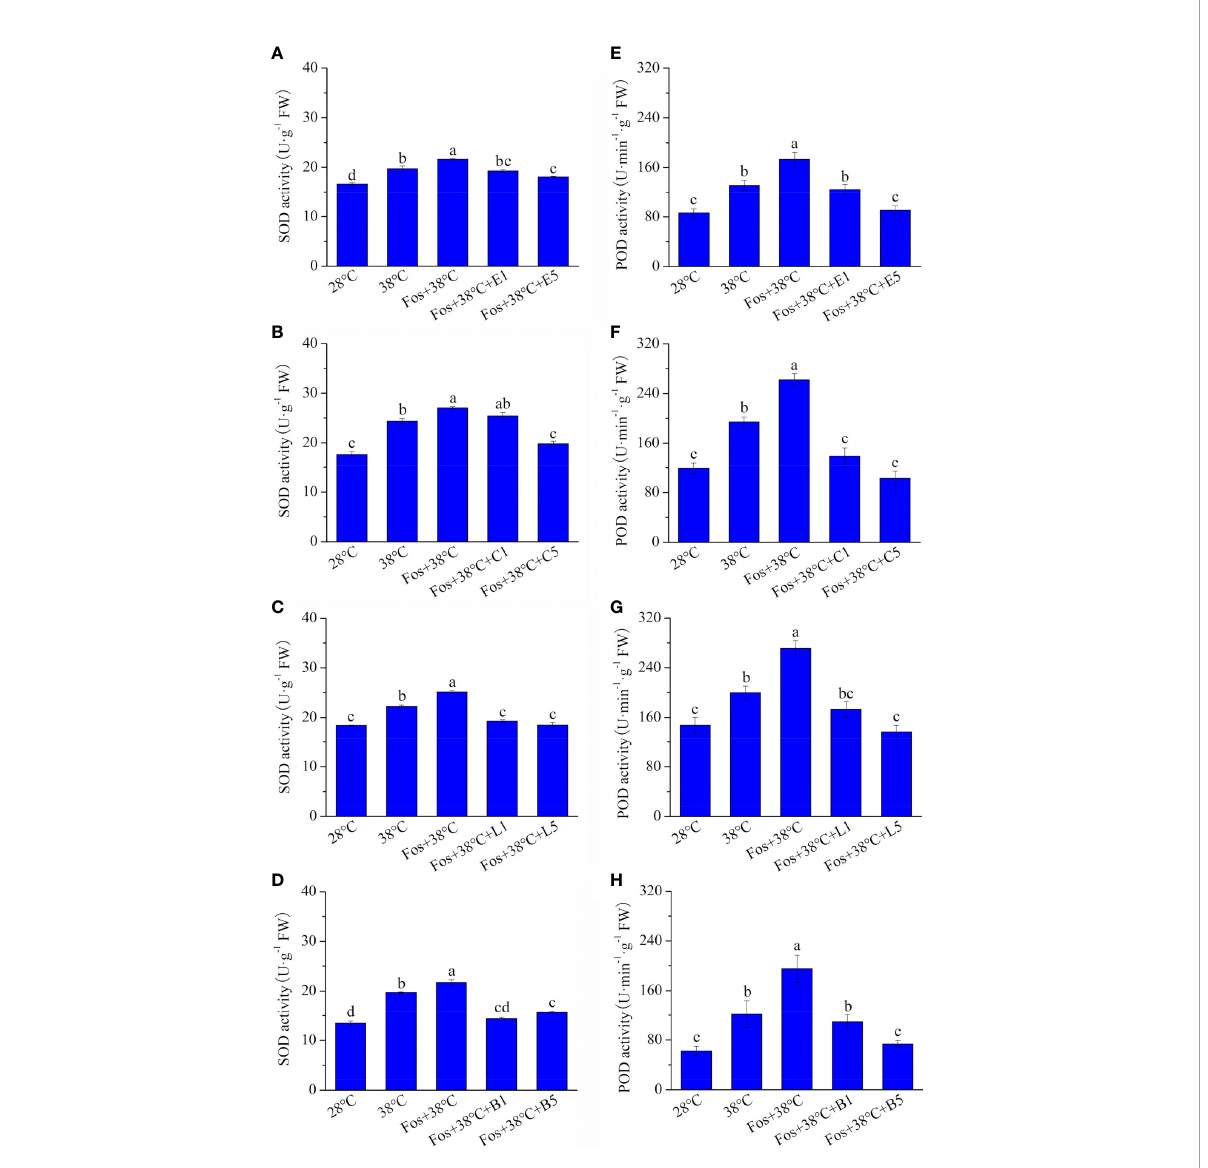
FIGURE 3 Effects of the uppermost monoterpenes on superoxide dismutase (SOD) (A – D) and peroxidase (POD) (E – H) activities in C. camphora . (A, E) Eucalyptol chemotype (EuL); (B, F) Camphor chemotype (CmR); (C, G) Linalool chemotype (LnL); (D, F) Borneol chemotype (BeL). 28°C, 38°C, and Fos+38°C: C. camphora was treated with normal temperature, high temperature, and high temperature with fosmidomycin (Fos) pretreatment, respectively. Fos+38°C+E1 and Fos+38°C+E5: EuL blocked monoterpene synthesis with Fos was fumigated with 1 and 5 m M eucalyptol at 38°C, respectively. Fos+38°C+C1 and Fos+38°C+C5: CmR blocked monoterpene synthesis with Fos was fumigated with 1 and 5 m M camphor at 38°C, respectively. Fos+38°C+L1 and Fos+38°C+L5: LnL blocked monoterpene synthesis with Fos was fumigated with 1 and 5 m M linalool at 38°C, respectively. Fos+38°C+B1 and Fos+38°C+B5: BeL blocked monoterpene synthesis with Fos was fumigated with 1 and 5 m M borneol at 38°C, respectively. Different lowercase letters indicate the signi fi cant difference at P < 0.05. Means ± SE (n =